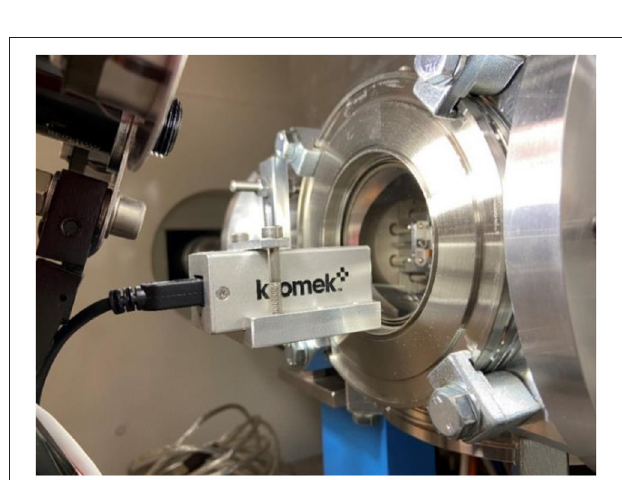
FIGURE 6 | MELISSA laser set-up operational since April 2019 (picture on the left) and laser resonance ionization scheme for actinium (picture on the right).